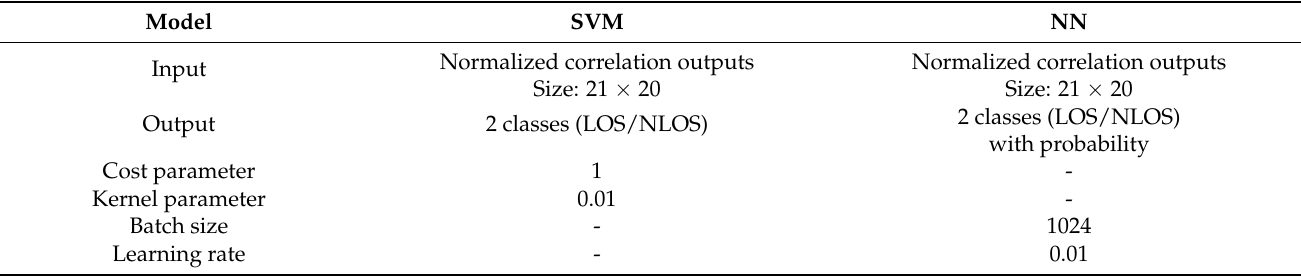
Table 1. Parameters for SVM and NN. The Cost parameter, Kernel parameter, and learning rate are the hyperparameters of SVM and NN.